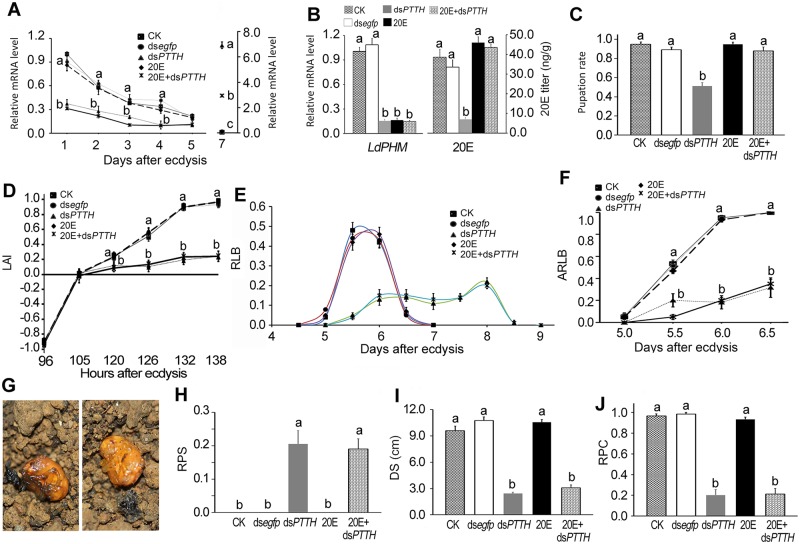
PTTH signal promotes light avoidance of the wandering larvae.PBS (CK), dsegfp, dsPTTH, 20E and dsPTTH+20E were dietarily introduced to the larvae. LdPTTH mRNA level (three repeats) (A), light avoidance index (LAI) (D), rate of larvae that had buried in soil per day (RLB) (E), and accumulated RBP (ARLB) (F) were determined at each testing time point demonstrating in Fig. LdPHM mRNA level and 20E titer (B) were tested at day 1 of the fourth-instar larvae. Pupation rate (C), rate of pupae at the soil surface (RPS) (G, H), average depths from pupation site to soil surface (DS) (I), and rate of pupae that had constructed pupation chambers (RPC) (J) were measured at the end of the experiment (P<0.05). Significant differences between blank control larvae (CK) and treatments are indicated by different letters (P<0.05).